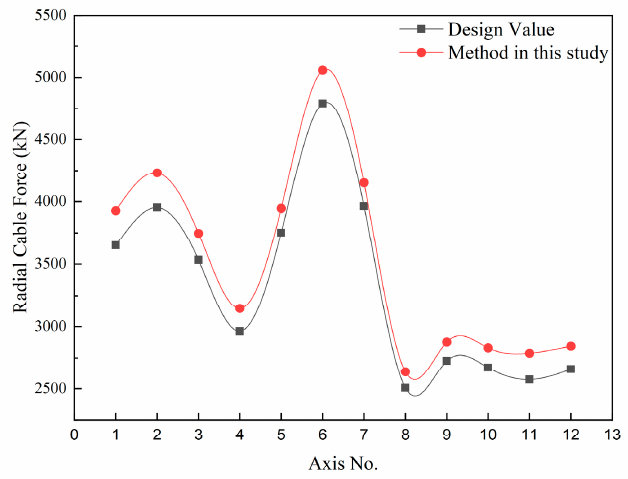
Figure 8. Radial cable force distribution after force-finding analysis.